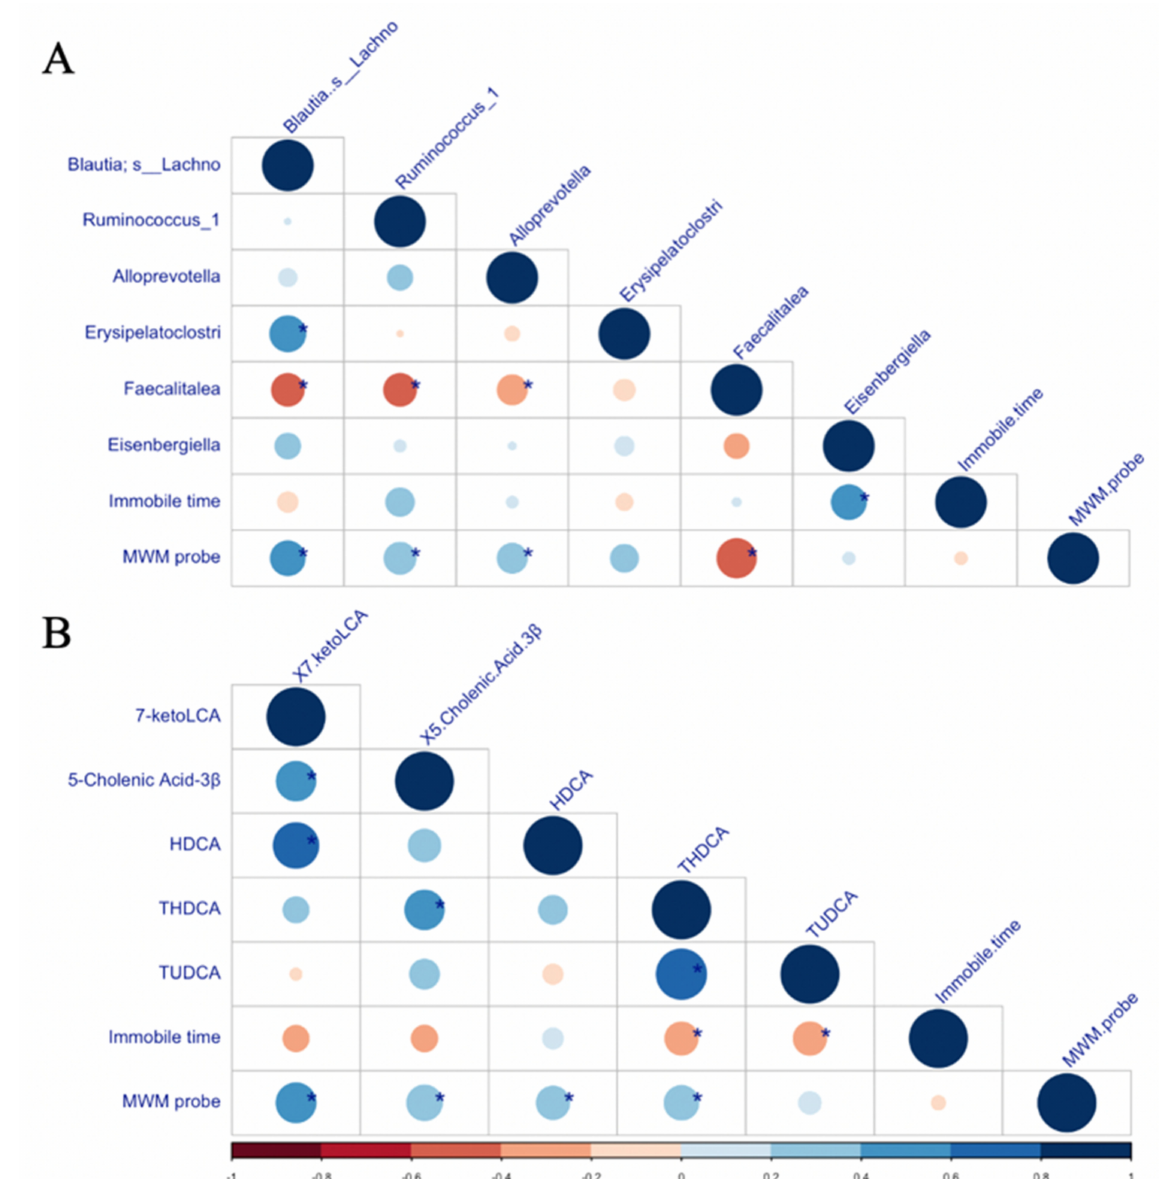
Figure 6. ( A ) The heatmap of Spearman’s correlation between the microbiota taxas and neurobe- havioural test results. ( B ) The heatmap of Spearman’s correlation between the bile acids and neurobe- havioural test results. Asterisk indicates significant differences between factors at p <